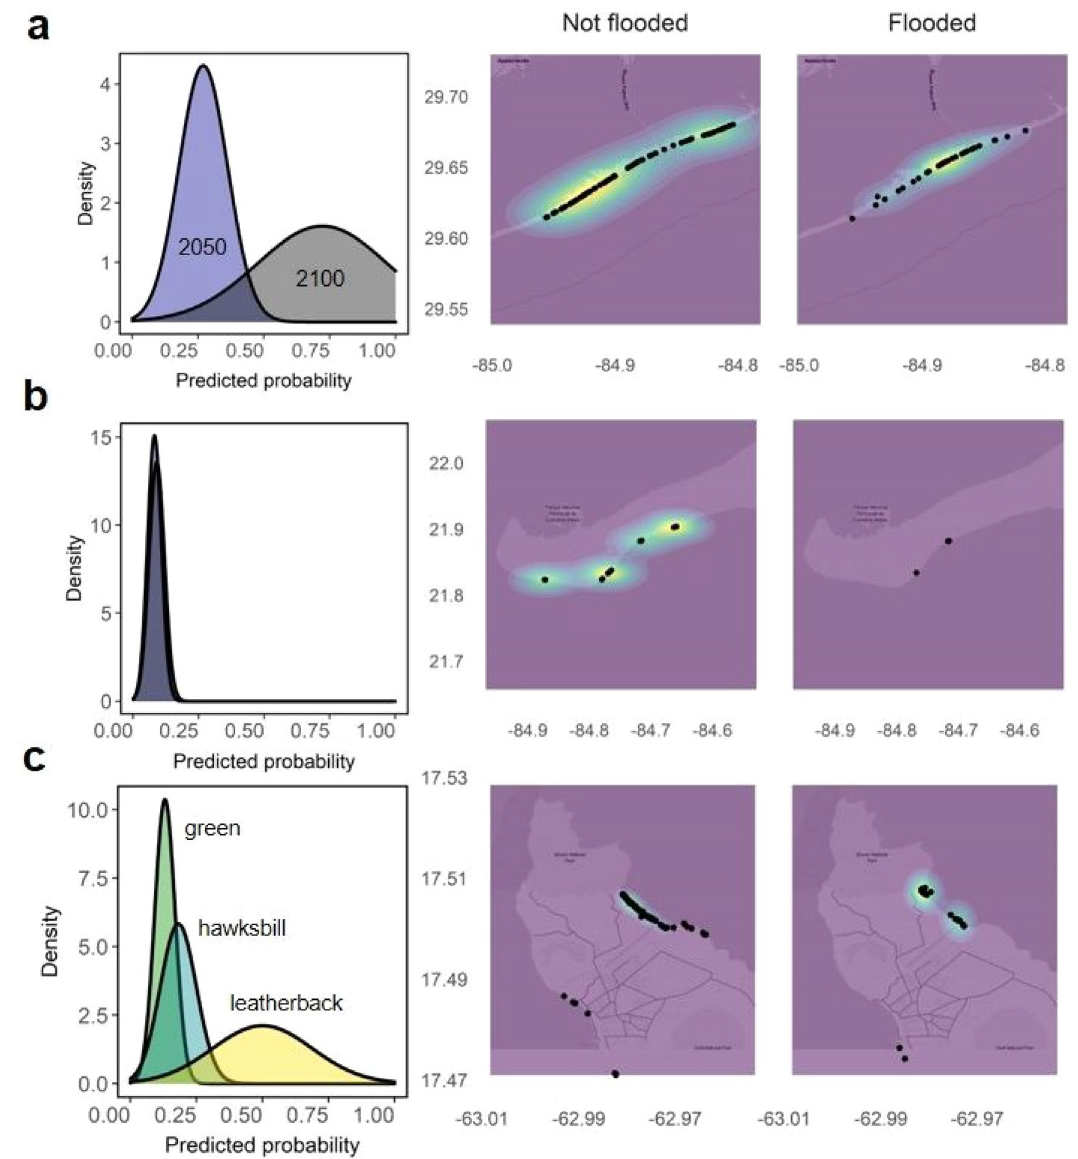
Figure 4. Predictions of sea turtle nest flooding in a subset of rookeries. Sites include ( a ) Florida (USA) (2050 and 2100), ( b ) Cuba (2050), and ( c ) St Eustatius (three species, 2050). Column 1: Proportion of nests likely to be flooded at each location. Column 2: Heatmap of nests predicted to be free from flooding by 2050. Column 3: Heatmap of nests predicted to be flooded by 2050, identifying the areas at highest risk. Probability values of 1 (yellow), 0.5 (blue) and 0 (purple) represent the density of unflooded or flooded nests within respective heatmaps. A Climate Central moderate scenario was adopted for these scenarios (Kopp et al.